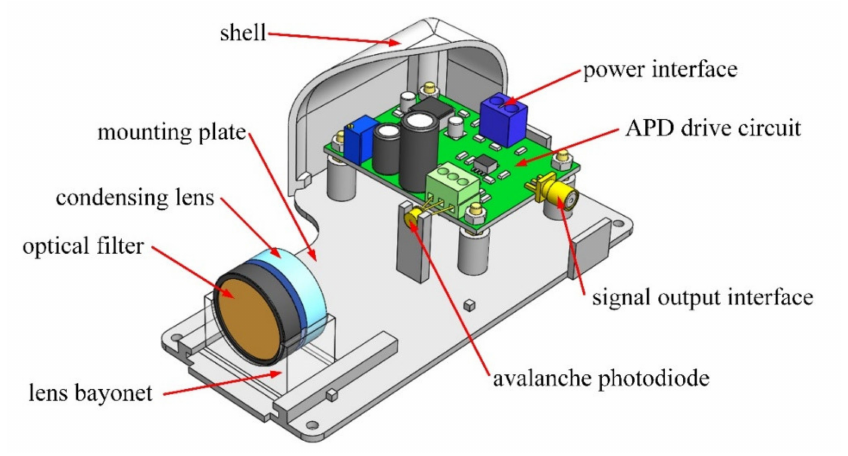
Figure 3. Structure of radiation intensity sensor.